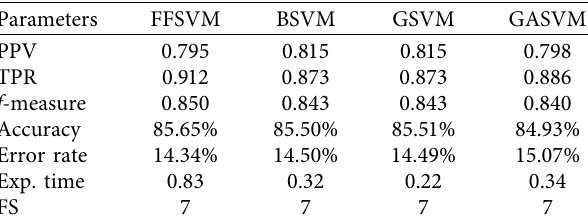
Table 5: Outcomes of the proposed algorithm and the three other algorithms (BSVM, GSVM, and GASVM) based on various pa- rameters such as PPV, TPR, f -measure, accuracy, error rate, ex- perimental time, and best-selected feature (FS).